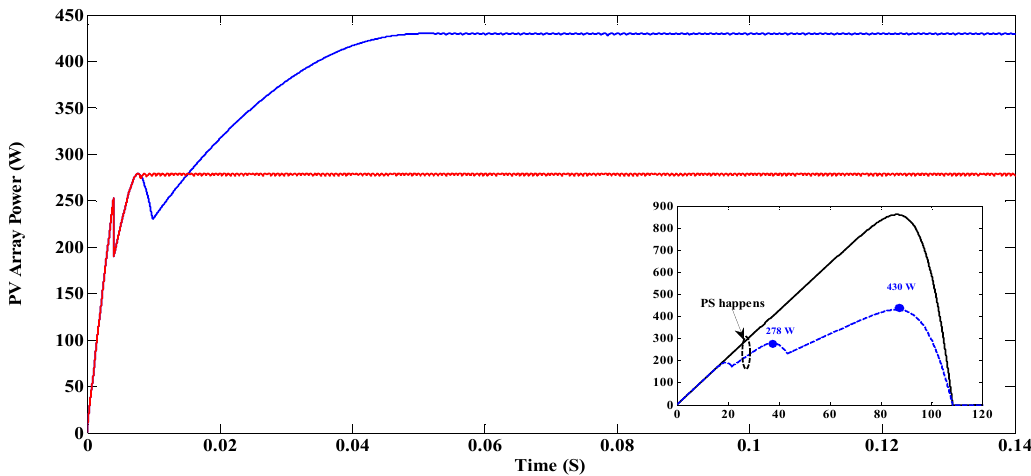
Figure 16. The PV output power for the scenario depicted in Figure 15.